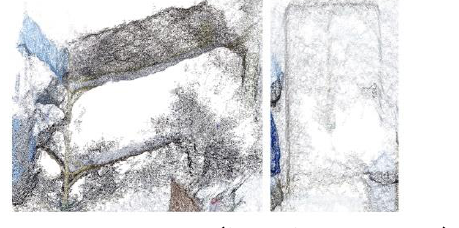
Figure 9. Examined details (from left: bed and doors)